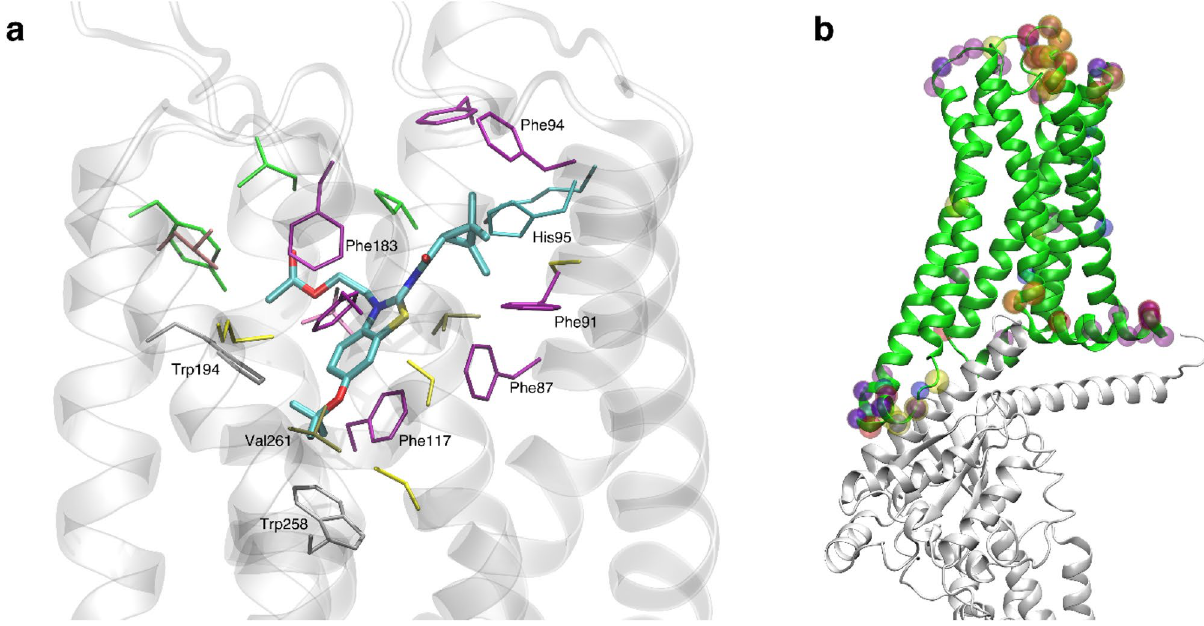
Figure 8. Depictions of ligand binding site and preferentially affected residues. ( a ) Representative snapshot of MRI-2659 in orthosteric binding site. MRI-2646 and MRI-2659 share common backbone position; ( b ) Cryo-EM structure (PDB: 6PT0) 44 . Those residues whose simulation average RMSD from the cryo-EM structure changed by > 1 Å as a function of 0% vs 40 mol% cholesterol are highlighted by spheres. Such residues from free and ligand-bound conditions (MRI-2594, MRI-2646, MRI-2659) are all shown. Note proximity to G α subunit (grey). A number of these residues reside in the extracellular loops; the functional relevance is not